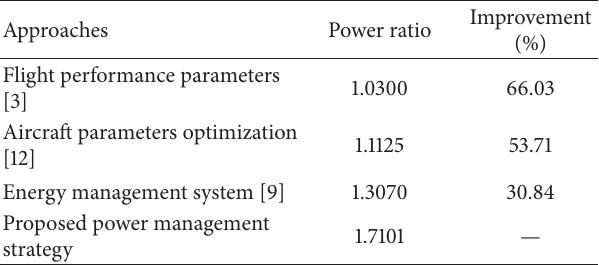
Figure 10: Recommended mission trajectory.